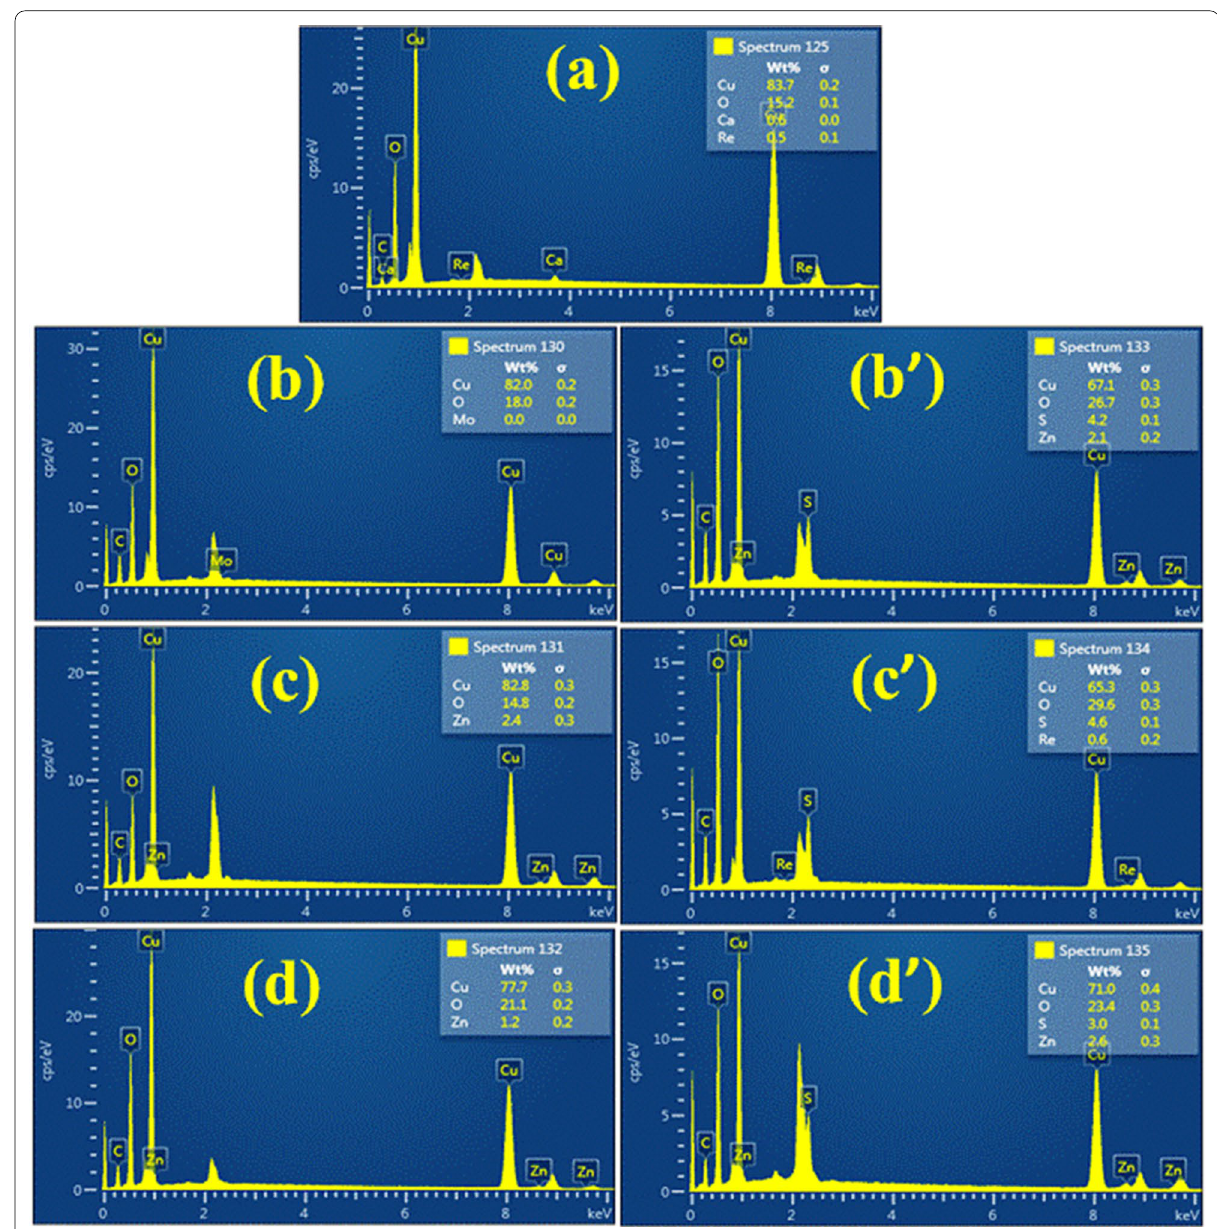
Fig. 6 EDS spectra of CuO NPs a pure CuO b – d ZO‑doped CuO and b ′ – d ′ AS‑doped CuO NPs,